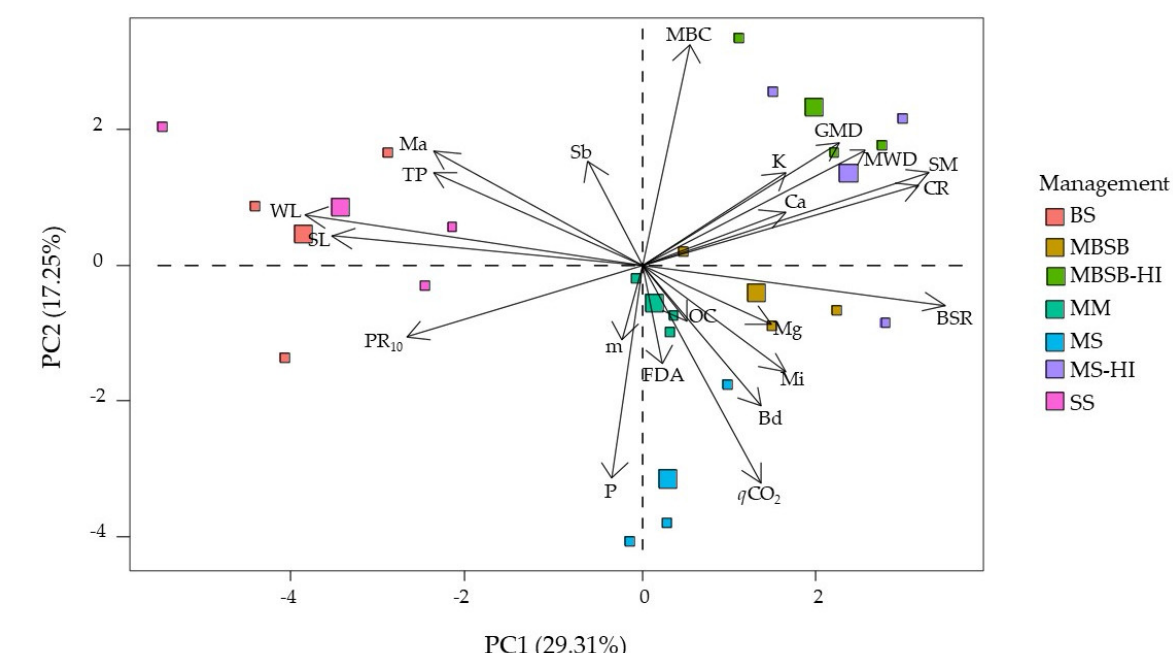
Figure 7. Principal component analysis for variables sampled in crop interrows. SL = soil losses, WL = water losses, CR = cover rate, MBC = microbial biomass carbon, BSR = basal soil respiration, q CO 2 = metabolic quotient, FDA = fluorescein diacetate hydrolysis, OC = soil organic carbon, Sb = sum of bases, m = aluminum saturation of soil, K = potassium, P = phosphorus, Ca = calcium, Mg = magnesium, MWD = mean weight diameter, GMD = geometric mean diameter, PR 10 = soil resistance to root penetration at 10 cm depth, SM = soil moisture in situ, TP = total porosity, Ma= macroporosity, Mi = microporosity, Bd = bulk density, SS = soybean monoculture, MM = maize monoculture, MS = maize/soybean rotation, MBSB = maize/brachiaria/soybean/brachiaria rotation, BS = bare soil, and HI = high input of